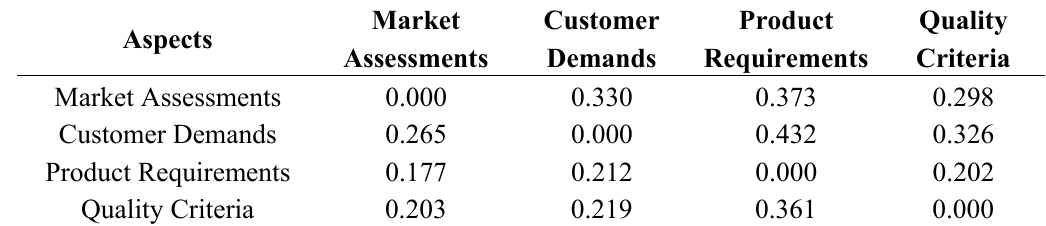
Table 3. Normalized Direct-Relation Matrix (X) for Aspects.